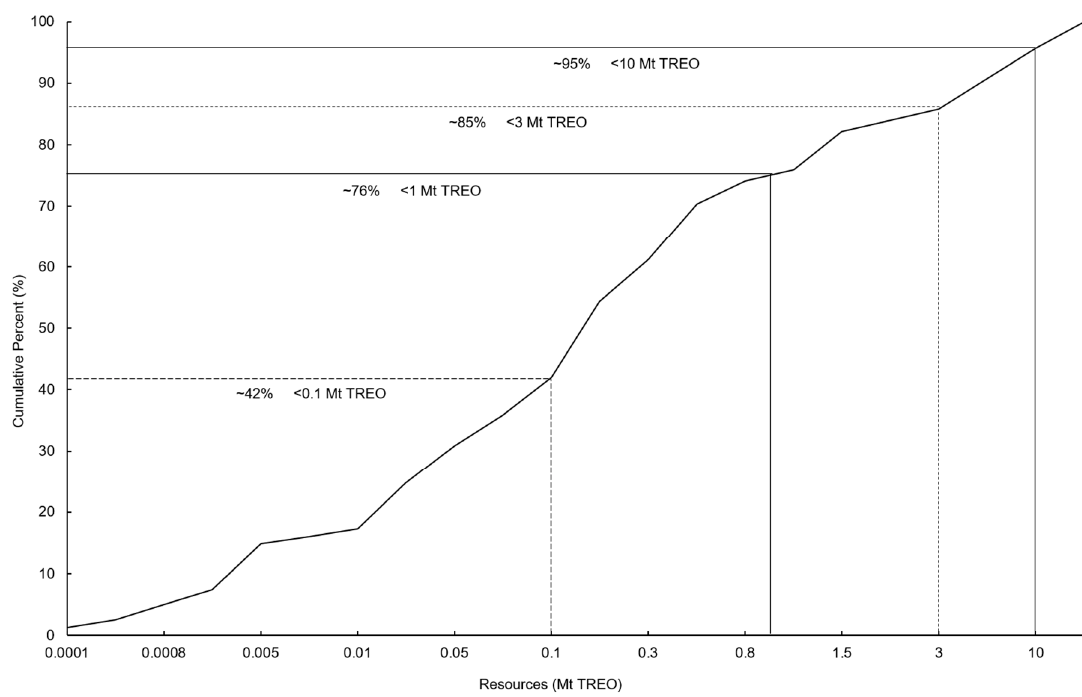
Figure 5. Cumulative frequency curves for the contained total rare earth elements (REE) resources.